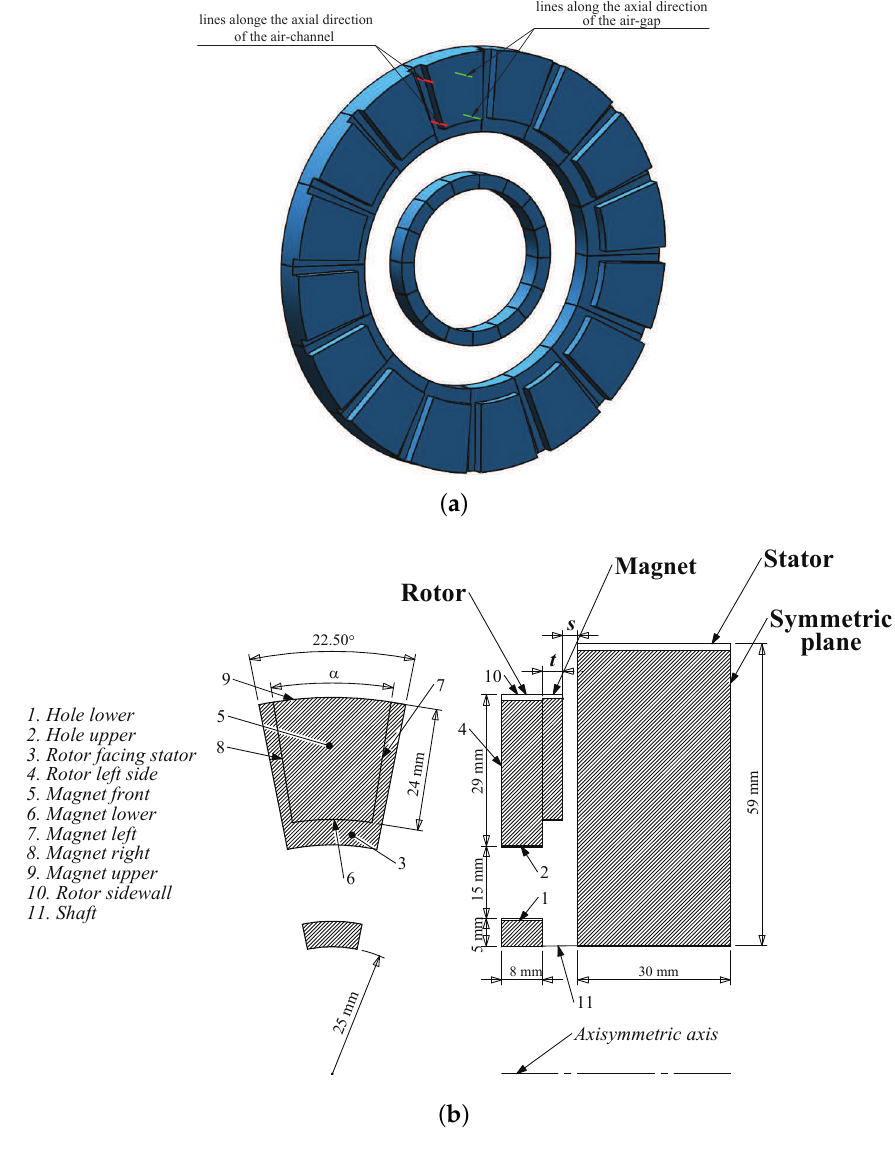
Figure 1. ( a ) The schematic diagram of the rotor in an AFPMSM; and ( b ) geometrical details of the current rotor-stator